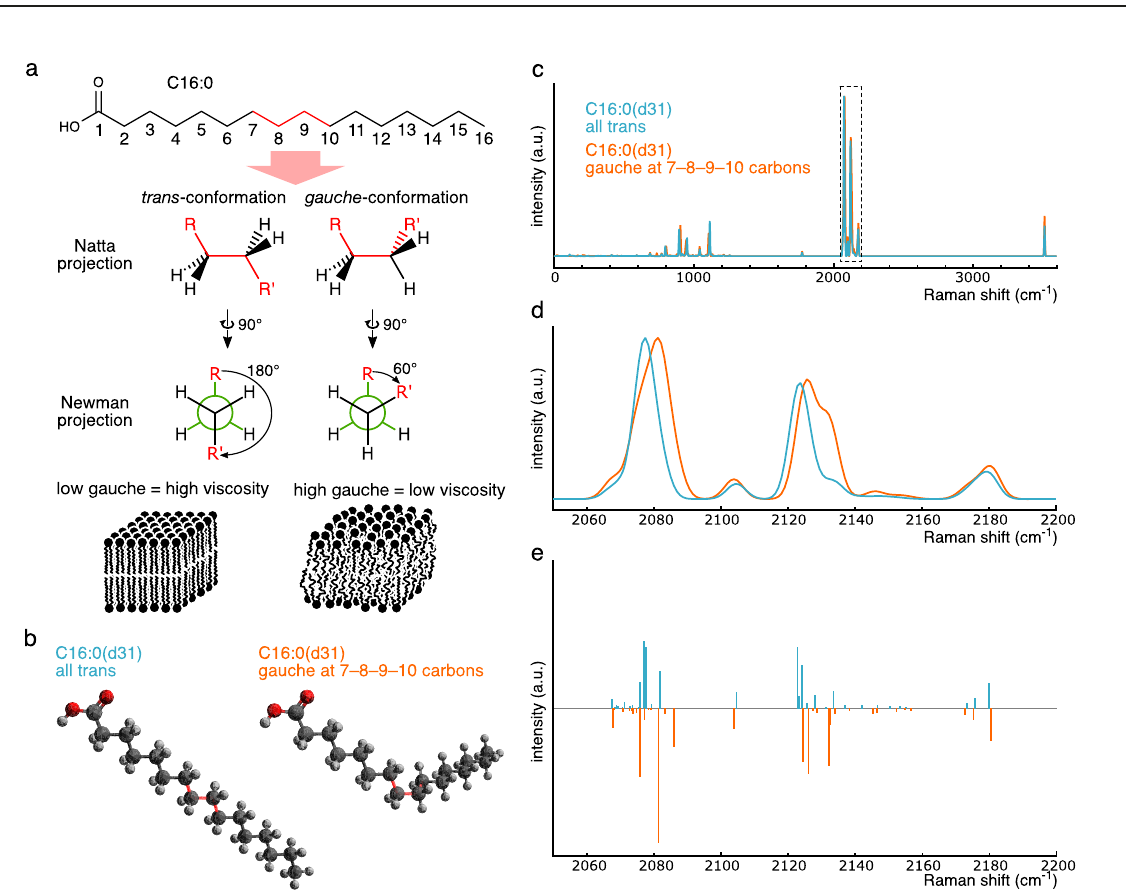
Fig. 2 Gauche/trans conformation affects the spectra of C – D vibration. a Schematic image of gauche/trans conformation and membrane viscosity. Gauche/trans conformation is shown with Natta and Newman projections. Lipid bilayers with a lower (left) and higher (right) gauche/trans ratio have higher and lower viscosity, respectively. The numbering of carbon atoms in C16:0 is displayed in the skeletal formula. b Structures of C16:0(d31) with all trans (left) and one gauche conformation at 7 – 8 – 9 – 10 consecutive carbons (right). Dark gray, light gray, and red atoms represent carbon, deuterium, and oxygen atoms, respectively. Chemical bonds between four consecutive carbon atoms corresponding to the skeletal formula in ( a ) are shown in red. c Raman spectra simulated using DFT. Magni fi ed view of the dashed box and its corresponding Raman activity are shown in ( d ) and ( e ), respectively. The intensity was normalized by equalizing prominent peak heights of the C – D vibration region. Graphs ( d ) and ( e ) are also shown in Fig. S2a, C18:1(d0) (Fig. S4a). These results indicate that the spectral transitions of C16:0(d31) re fl ect more than the phase differences and represent some continuous physical properties of lipids.